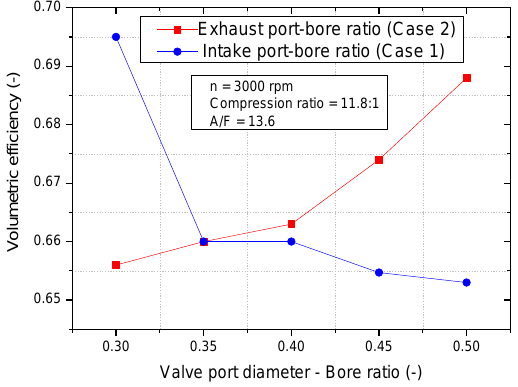
Figure 11. Volumetric efficiency versus VPD/B.